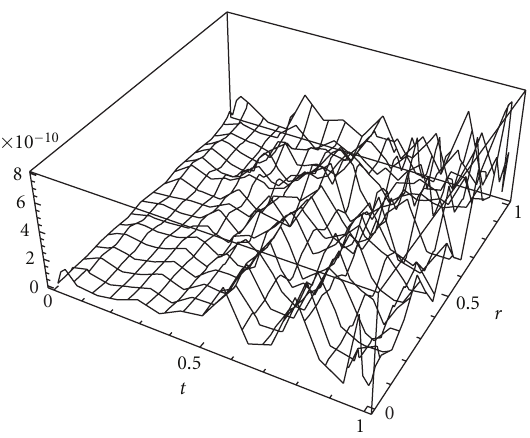
Figure 27: Absolute error of Y